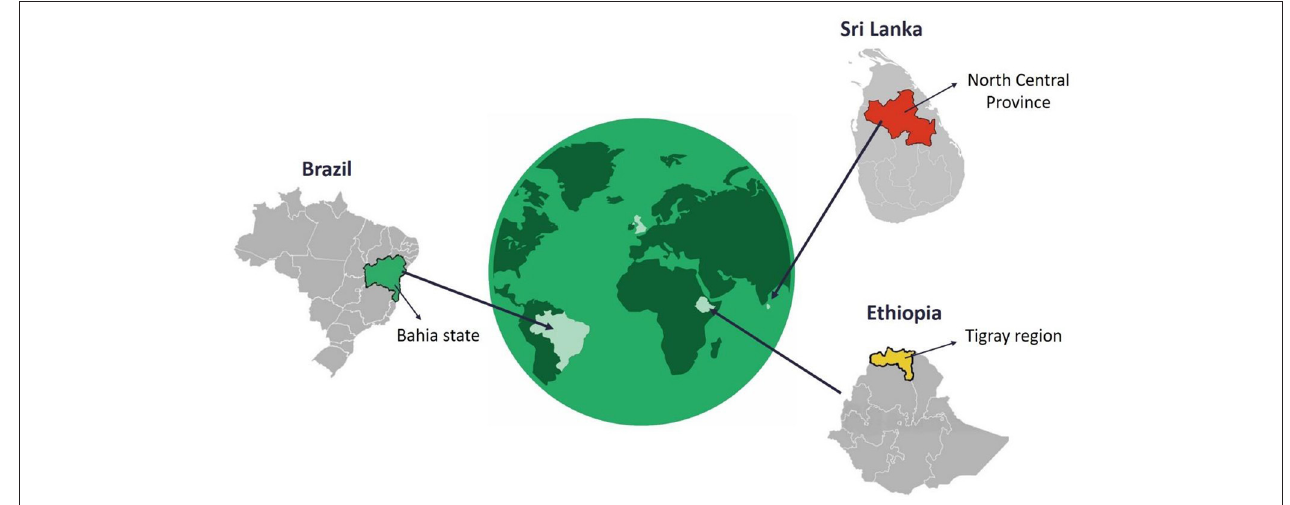
FIGURE 3 | Location of ECLIPSE hubs in the three CL-endemic